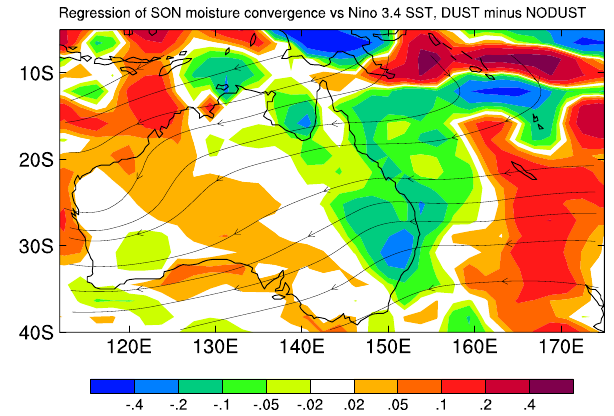
Fig. 12. Difference of the regression slopes of moisture conver- gence versus Ni˜no3.4 SST between the DUST and NODUST runs for SON (shading, in mm per day per Kelvin). Streamlines show the regression against Ni ˜ no3.4 SST of moisture advection by the mean SON flow in the DUST run, integrated from the surface to ap- proximately 700hPa. On the streamlines, the arrows are reversed, to show the direction of enhanced moisture transport under La Ni˜na